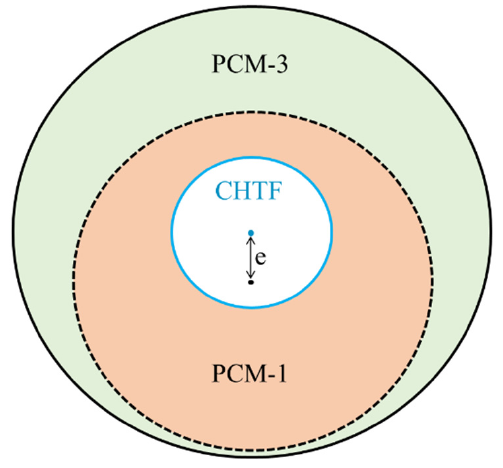
Figure 9. Eccentric configuration of the sector tube.